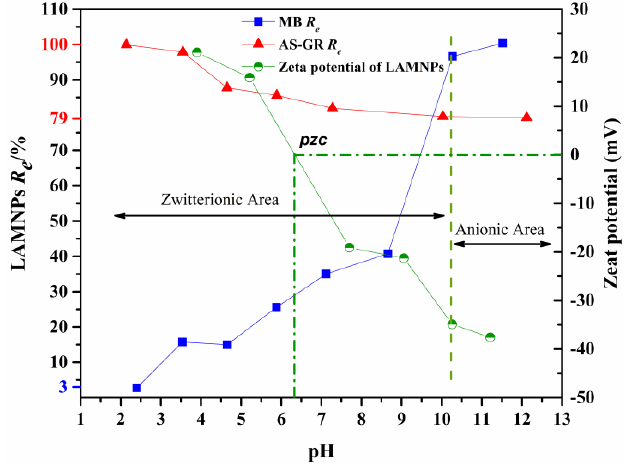
Figure 7. Removal efficiency of cationic and anionic dyes using LAMNPs and zeta potential of LAMNPs as a function of solution pH (the maximum and minimum removal efficiencies of MB and AS-GR are indicated as blue and red labels, respectively).